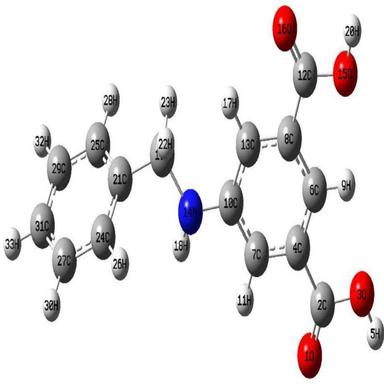
Optimized molecular geometrical structure with atom numbering.